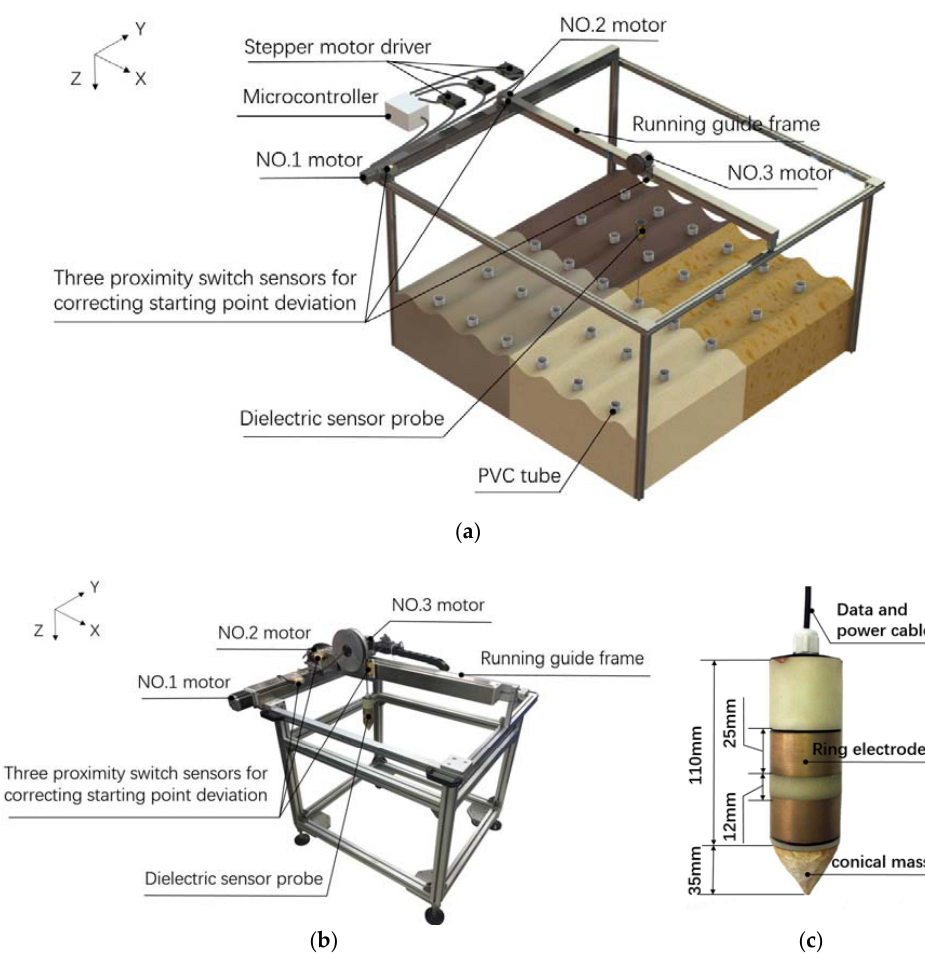
Figure 1. ( a ) Framework diagram of the three-dimensional tomography system; ( b ) photograph of the system and ( c ) the dielectric probe.